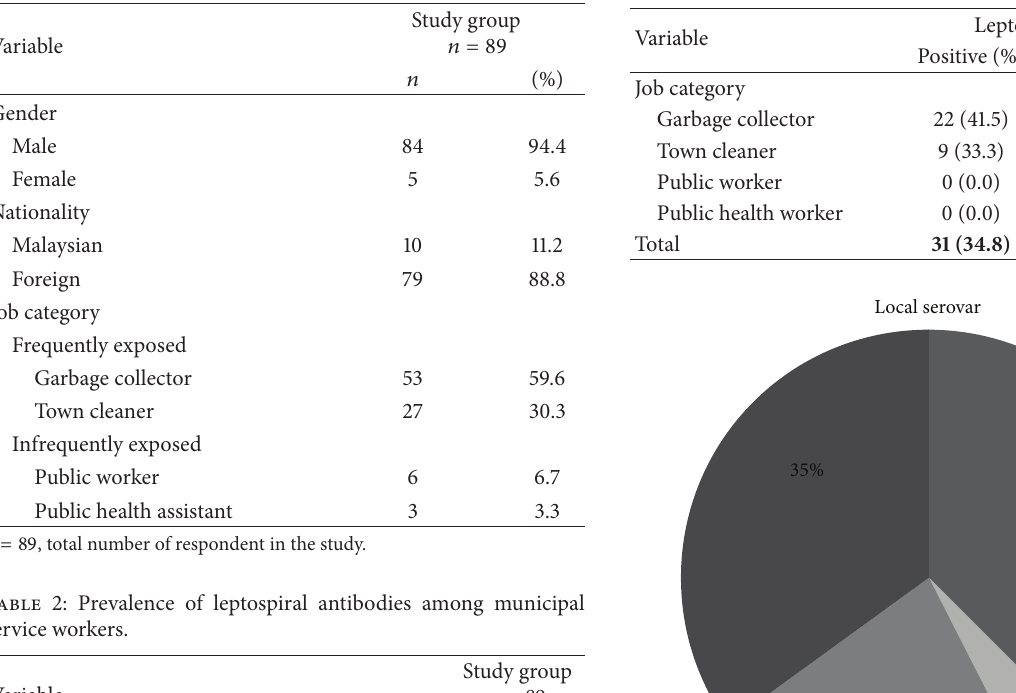
Table 1: Sociodemographic characteristic of municipal service workers.